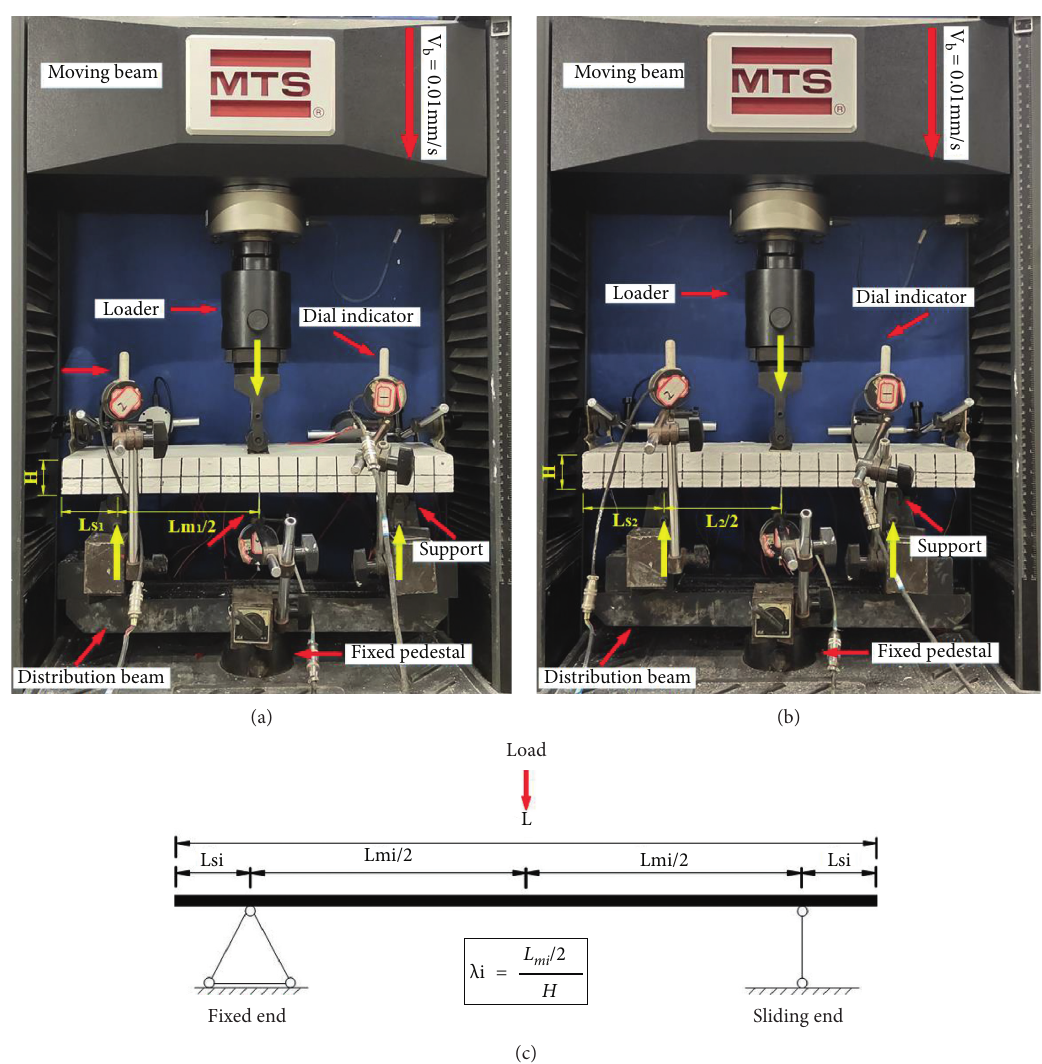
Figure 3: Loading scheme and design of ratio of shear span. (a) Ratio of shear span to depth ( λ ( λ 2 � 3.33). (c) Design ratio of shear span to depth ( λ 1